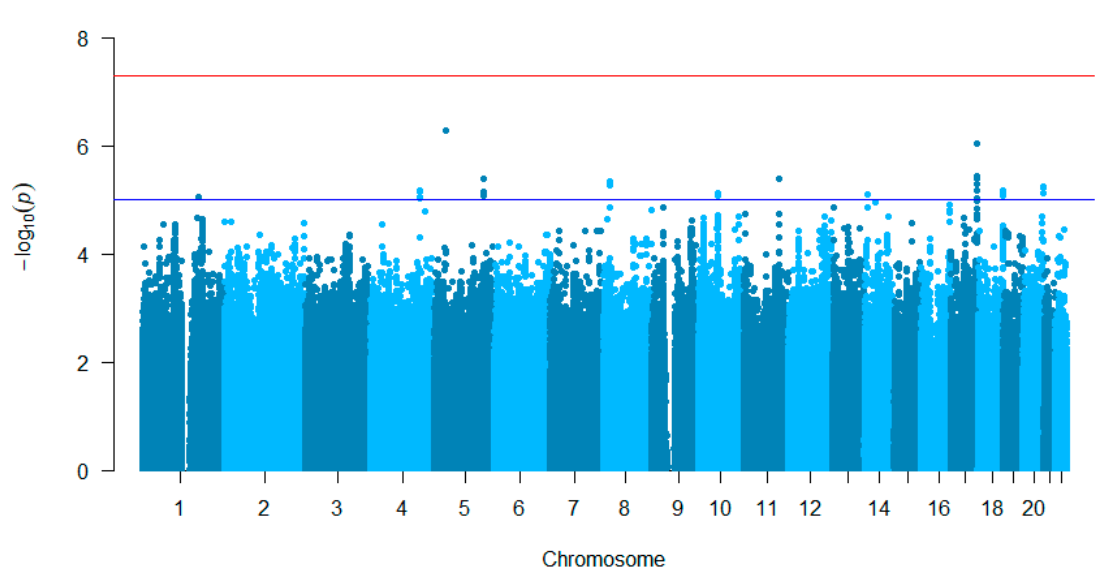
Figure 2. Results of GWAS investigating lowest magnesium plasma level after platinum treatment. The p -values were generated using logistic regression. The Manhattan plot shows the associations between lowest magnesium plasma level and genetic variants (blue dots), plotted against chromoso- mal position (x-axis) and -log10 p -value (y-axis). The red line represents the p -value threshold for genome-wide statistical significance after Bonferroni correction for multiple testing ( p < 5 × 10 − 8 ), with no genetic variants surpassing this threshold. The blue line represents a suggestive p -value threshold ( p < 10 − 5 ), with 35 hits surpassing this threshold (representing 11 independent loci). The top hit is the genetic variant, RAI4 rs563097889, on chromosome 5 ( p = 5.16 × 10 − 7 ).